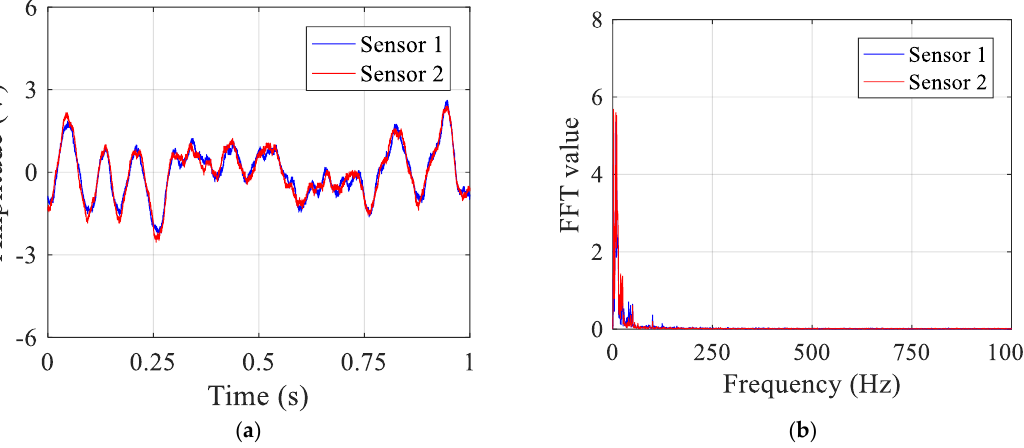
Figure 10. Test signals in the pipe without leakage: ( a ) in the time domain; and ( b ) in the frequency domain.